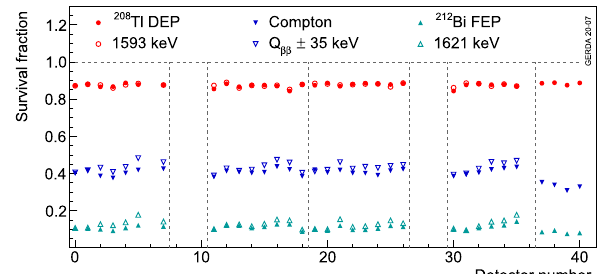
Fig. 6 Energy distribution of events from calibration data before and after the A / E cut (top) and their ratio (bottom) for BEGe and IC detec- tors